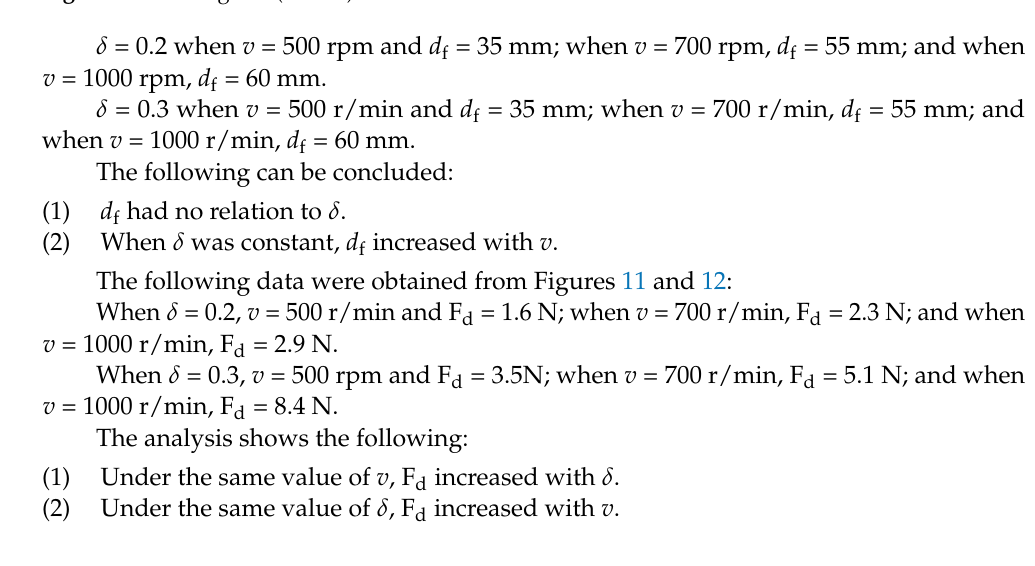
Figure 12. F- d diagram ( δ = 0.3).